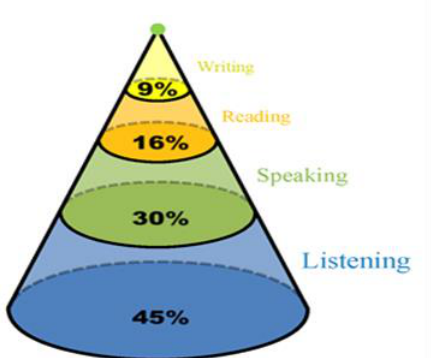
Fig. 3. A fragment of dialogue between native speakers of different languages.